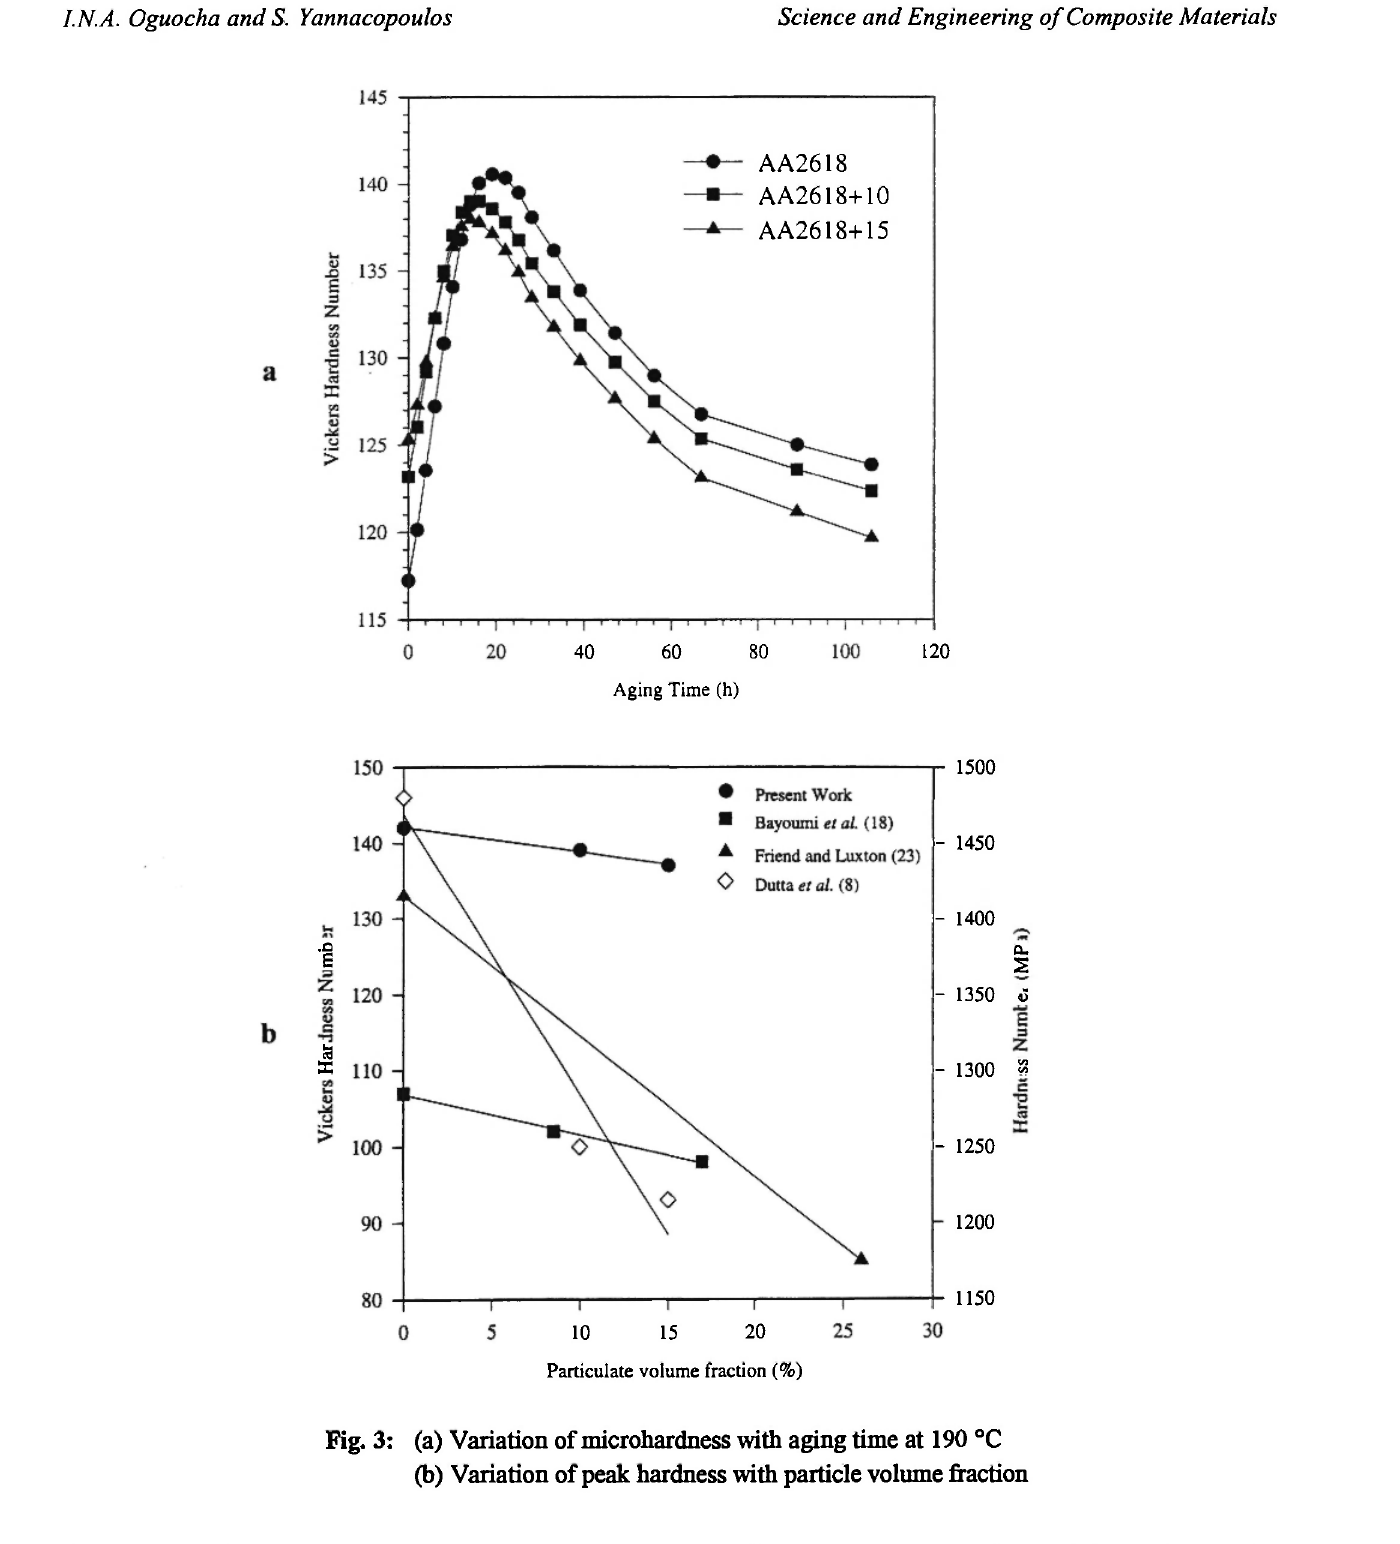
Fig. 3: (a) Variation of microhardness with aging time at 190 °C (b) Variation of peak hardness with particle volume